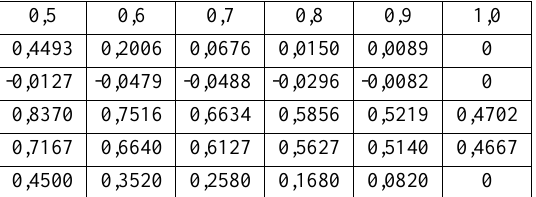
Table 2 . Continuation